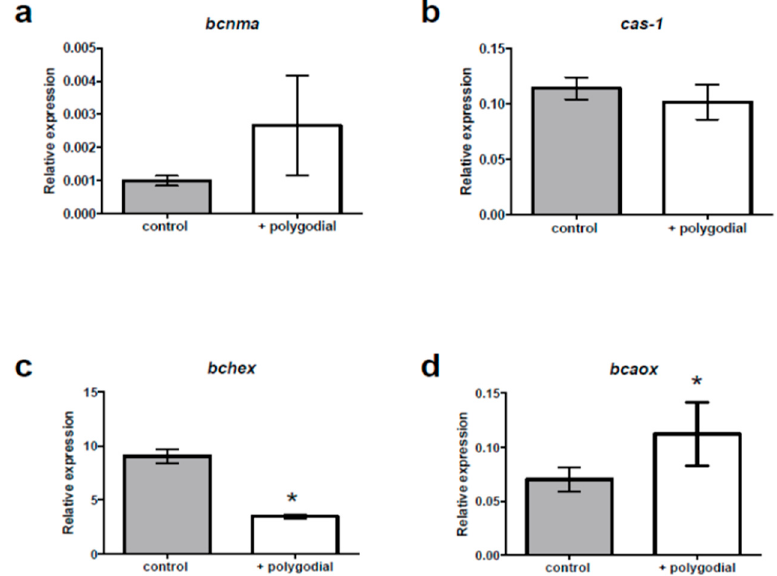
Figure 8. Effect of polygodial on gene expression of Botrytis cinerea. mRNA levels of b c nma ( a ), cas-1 ( b ), b c hex ( c ), and b c aox ( d ) genes were measured in presence and the absence of polygodial after 1 h of incubation. All values represent the mean ± standard deviation of three independent experiments with at least three replicates each. (*) Represents experiments with a significant difference between control and polygodial treatments at the 0.05 significance level (Student’s t -test).